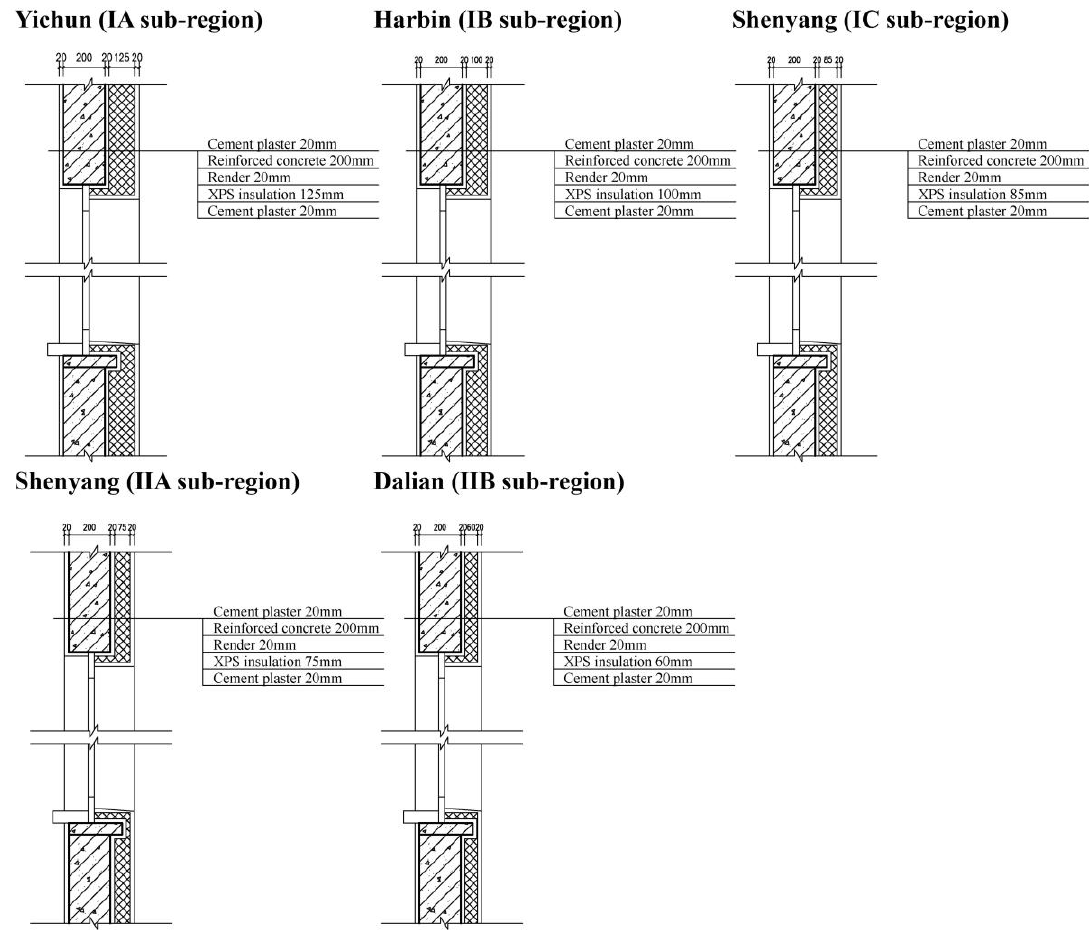
Figure 5. Configuration of external wall in the five cities. Table 5. U-values of building envelope in the simulation settings.